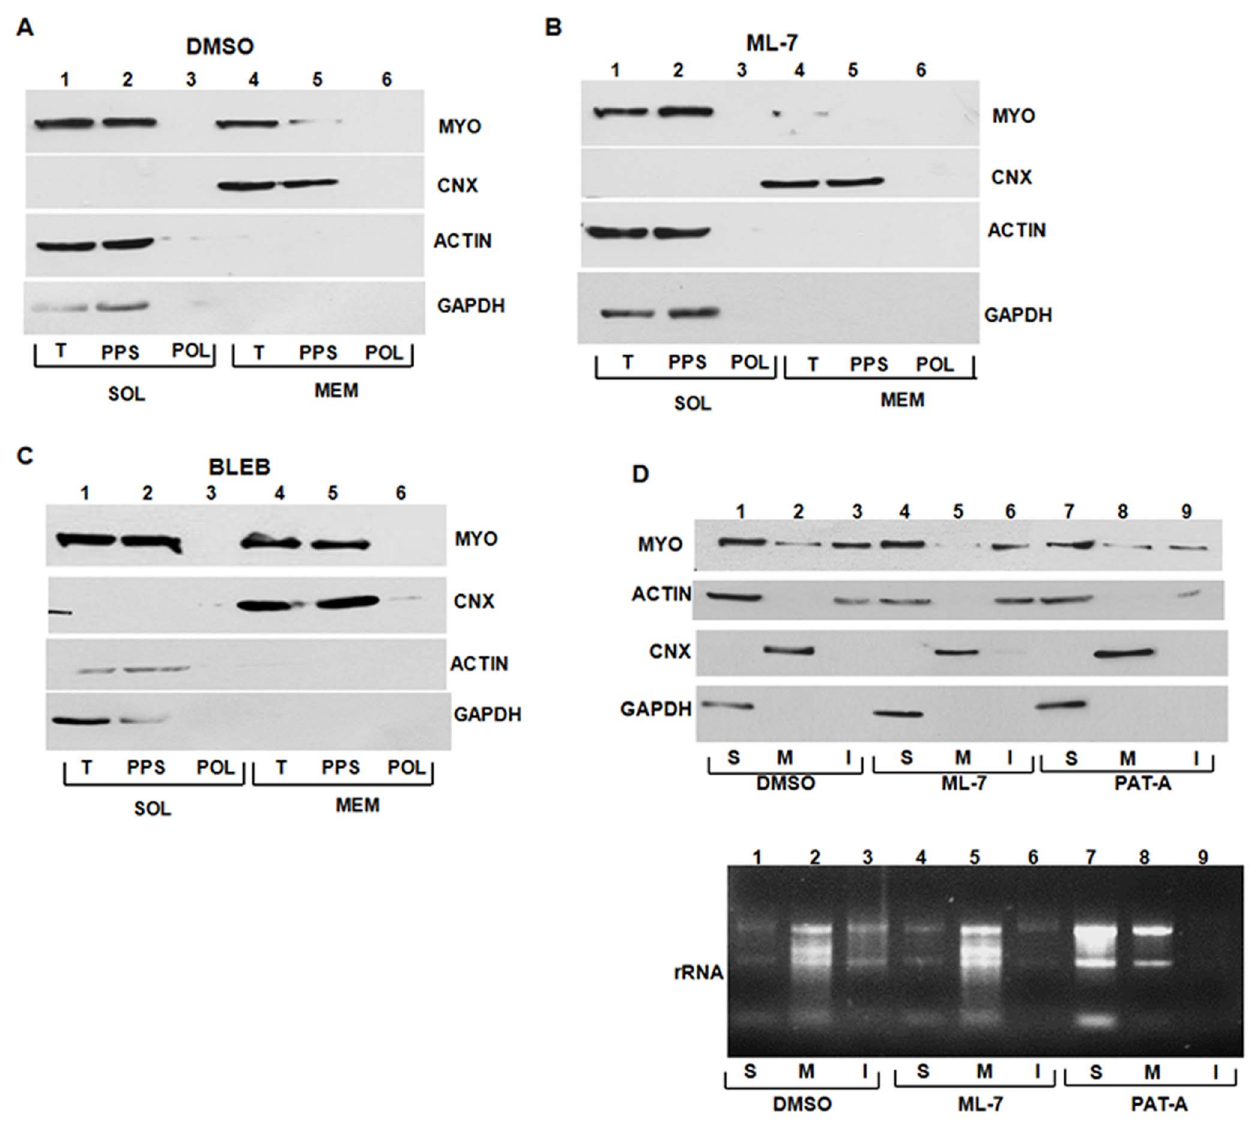
Figure 7. Association of nonmuscle myosin with internal membranes. A. Distribution of nonmuscle myosin in cytosolic and membrane fractions of HLFs. HLFs were fractionated into cytosolic (SOL) and membrane (MEM) fractions and the total fractions (T) were analyzed in lanes 1 and 4. Polysomes (POL, lanes 3 and 6) and post-polysomal supernatant (PPS, lanes 2 and 5) were furthered separated from the total fractions and the samples were analyzed for myosin IIb (MYO) by western blot. Calnexin (CNX) was analyzed as a marker of membrane fraction and actin (ACT) and GAPDH as a markers of cytosolic fraction. B. Disappearance of nonmuscle myosin from the membrane fraction after ML-7 treatment. Experiment as in A, except HLFs were treated with ML-7. C. Effect of blebbistatin on membrane association of myosin IIb. Experiment as in A, except HLFs were treated with blebbistatin. D. ML-7 treatment does not increase insoluble nonmuscle myosin. Upper panel: distribution of nonmuscle myosin (MYO), actin (ACT), calnexin (CNX) and GAPDH proteins in soluble (S), membrane (M) and NP-40 insoluble (I) fractions of control cells (lanes 1–3), ML-7 treated cells (lanes 4–6) and Pat-A treated cells (lanes 7–9). Bottom panel: distribution of ribosomal RNA.